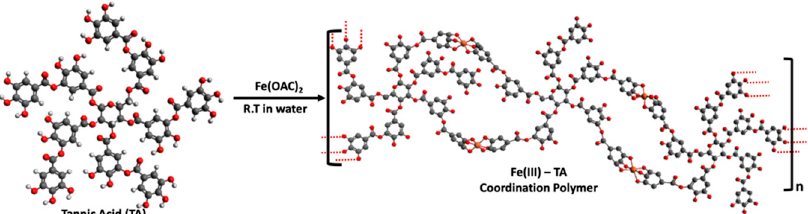
Scheme 1. Synthesis scheme for the formation of Fe(III)-TA by catenating tannic acid with Fe +2 .